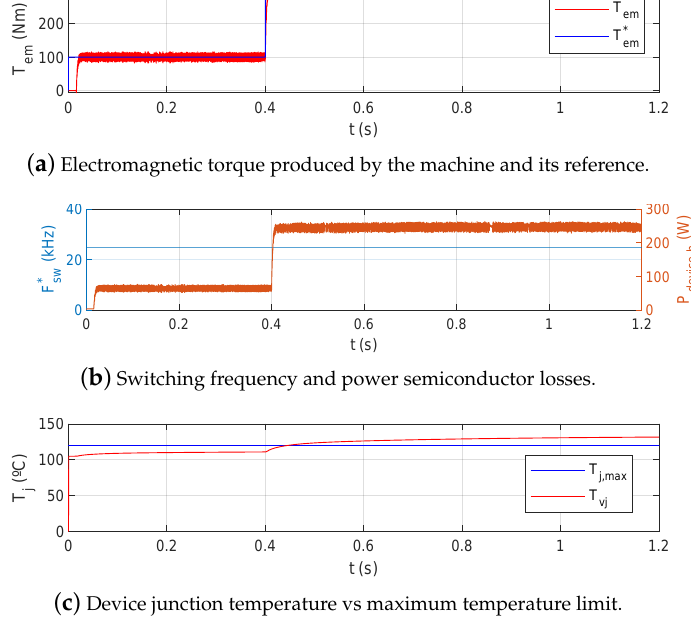
Figure 5. Simulation results obtained at very low speed and under a high torque step without using the proposed TCT algorithm.